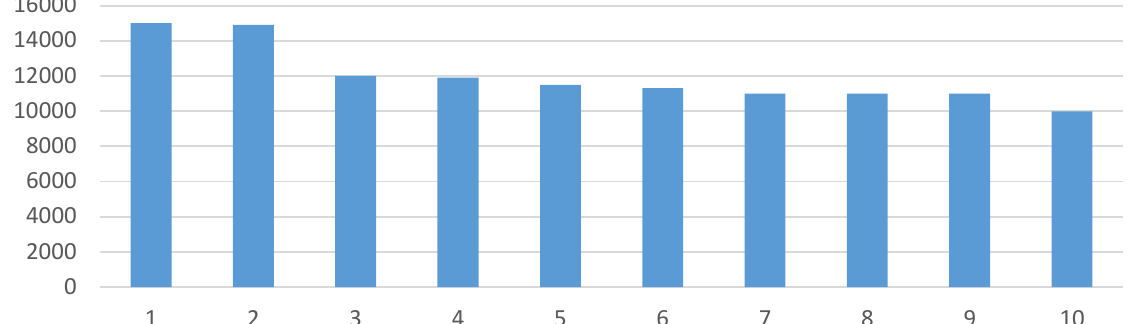
Figure 3. The cost of one-year study on the specialty “Management” in IHE of